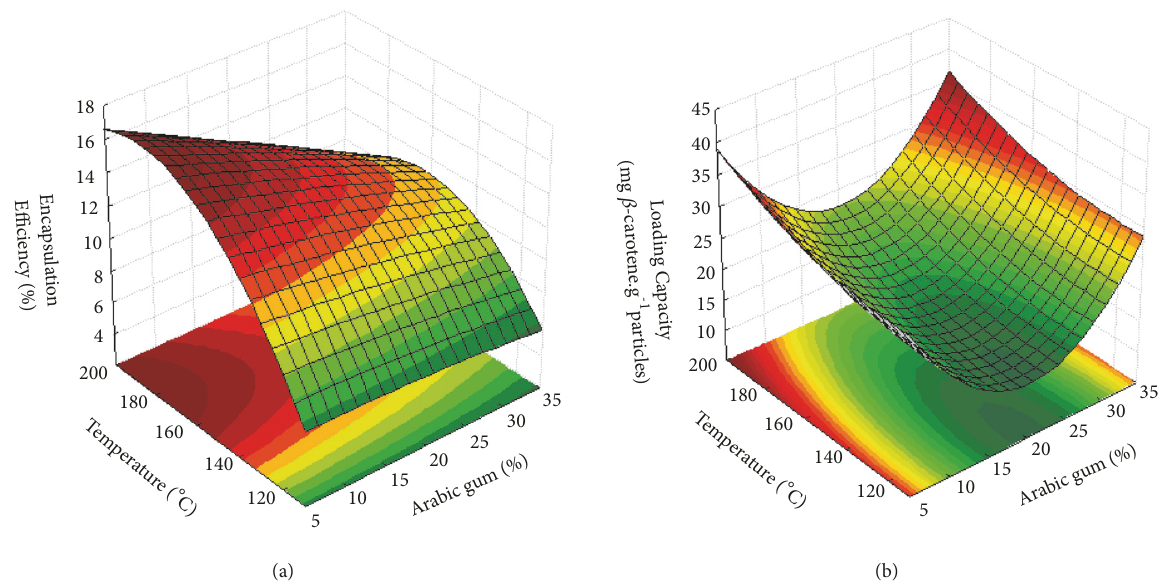
Figure 4: Response surface fitted to (a) encapsulation efficiency and (b) loading capacity, as a function of Arabic gum concentration and drying inlet temperature.